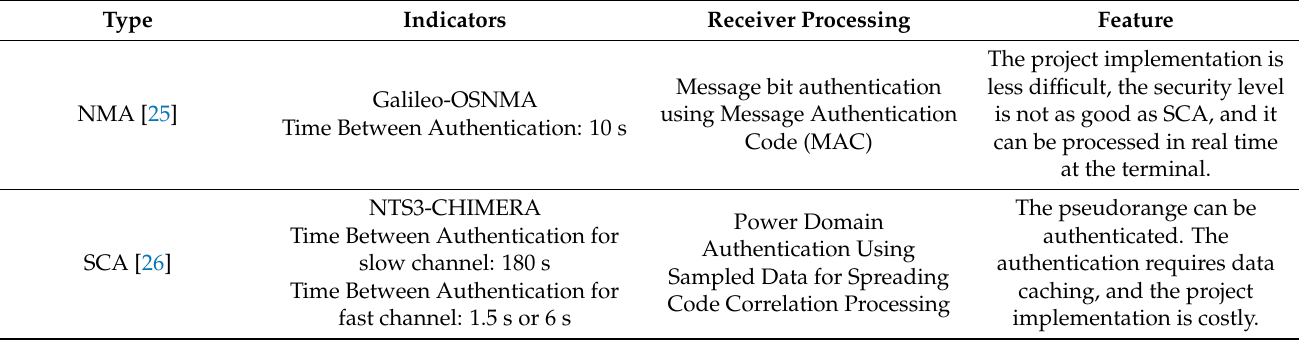
Table 1. Comparison of NMA and SCA.